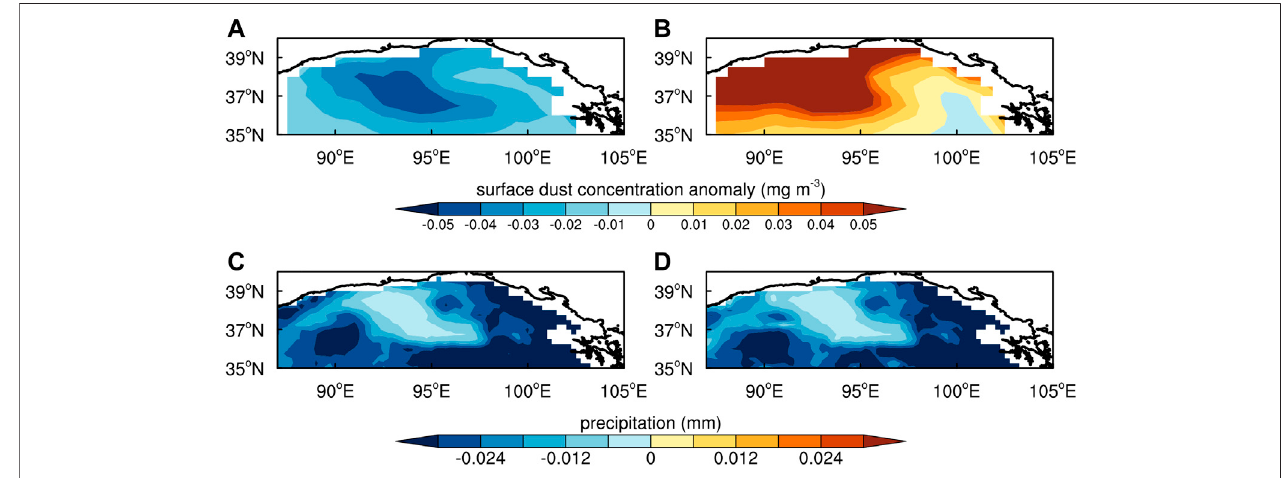
FIGURE9| Spatialdistributionsof (A,B) surfacedustconcentration(units:mg m − 3 )and (C,D) precipitation(units:mm)on( fi rstcolumn)thedifferencebetweenhigh and normal days and (second column) the difference between low and normal days.